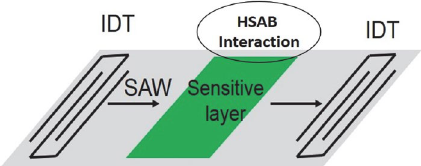
Figure 1. The structure of SAW